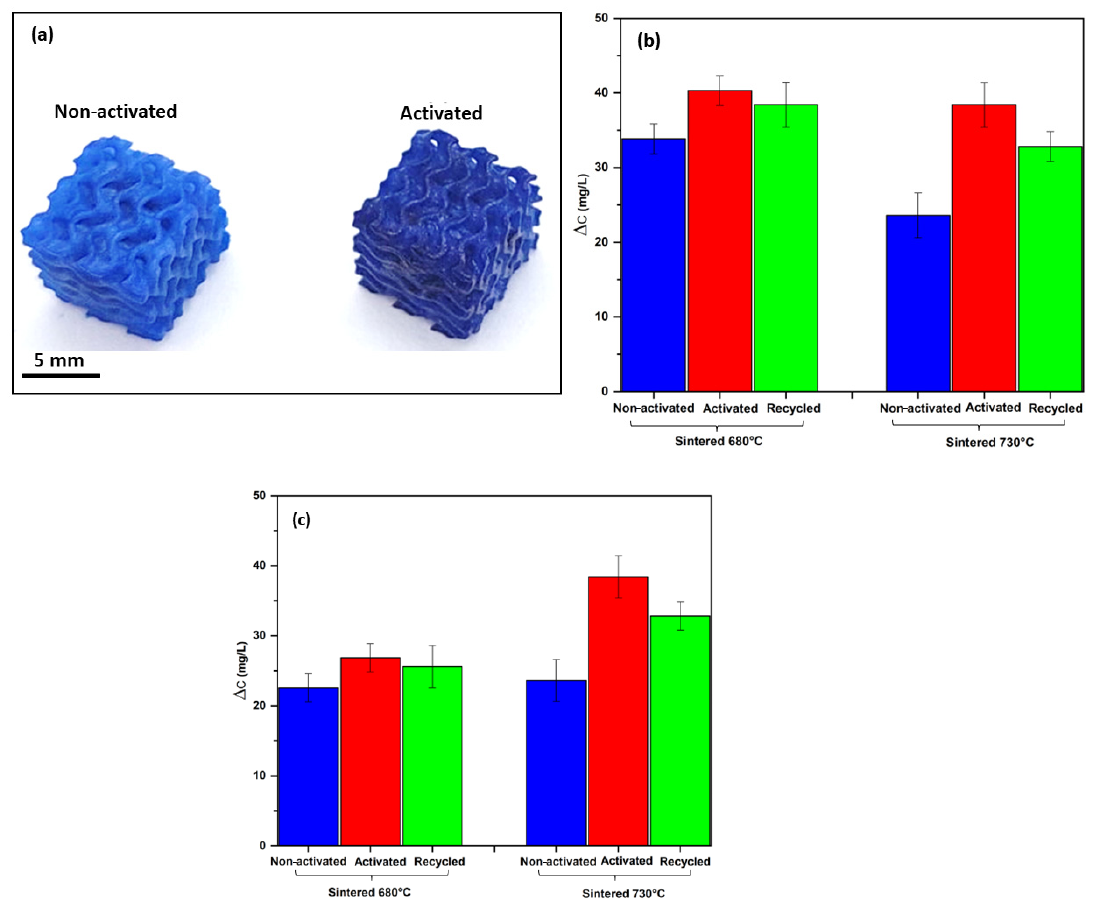
Figure 4. ( a ) Adsorption of methylene blue of activated and non-activated printed gyroid fired at 730 °C; ( b ) the uptake of methylene blue by the same weight of non-activated, activated and recycled gyroids; ( c ) the uptake of methylene blue by the same volume of non-activated, activated and recycled gyroids.